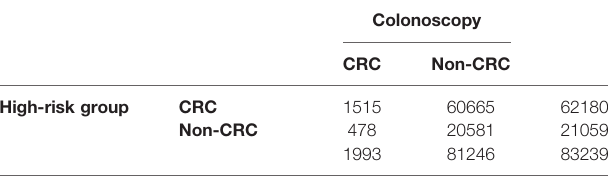
TABLE 9-6 | Analysis of CRC detected in high-risk groups versus CRC diagnosed by colonoscopy results, n (%).